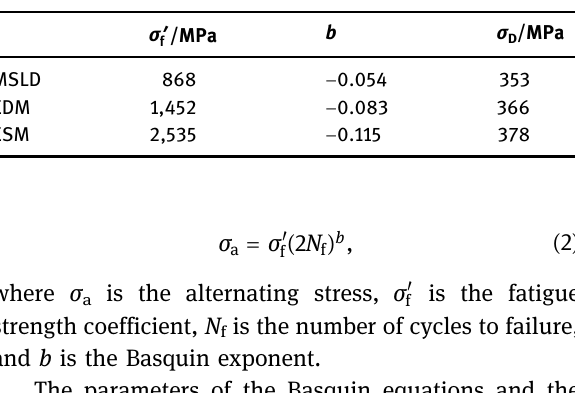
Table 1: Parameters of the Basquin equations and fatigue limits